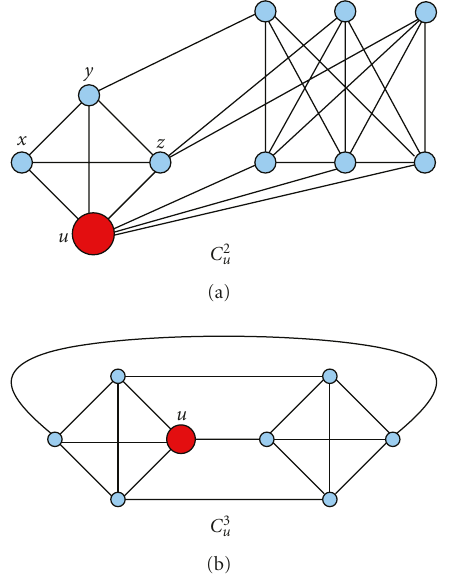
Figure 1: (a) Order should be picked carefully for C 2 . exists for C 3 u